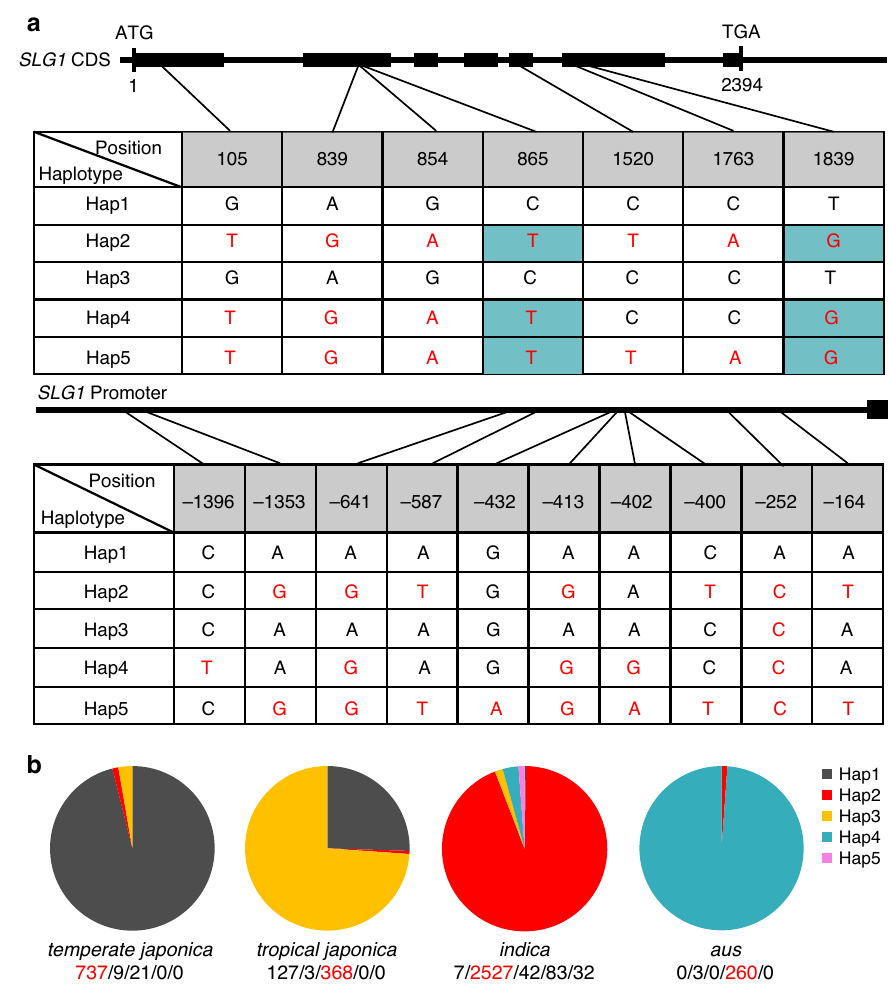
Fig. 3 SLG1 is differentiated in Asian cultivated rice. a Haplotype analysis of SLG1 promoter and coding regions from 4219 Asian cultivated rice accessions. Red letters indicate different nucleotides, and gray-marked letters indicate non-synonymous substitutions. b Distribution frequency of the fi ve SLG1 haplotypes in diverse Asian cultivated rice collection. The number of cultivars for each haplotype was given from left to right below each subpopulation. The haplotype with the largest number was highlighted in red. The source data underlying ( b ) are provided as a Source data fi